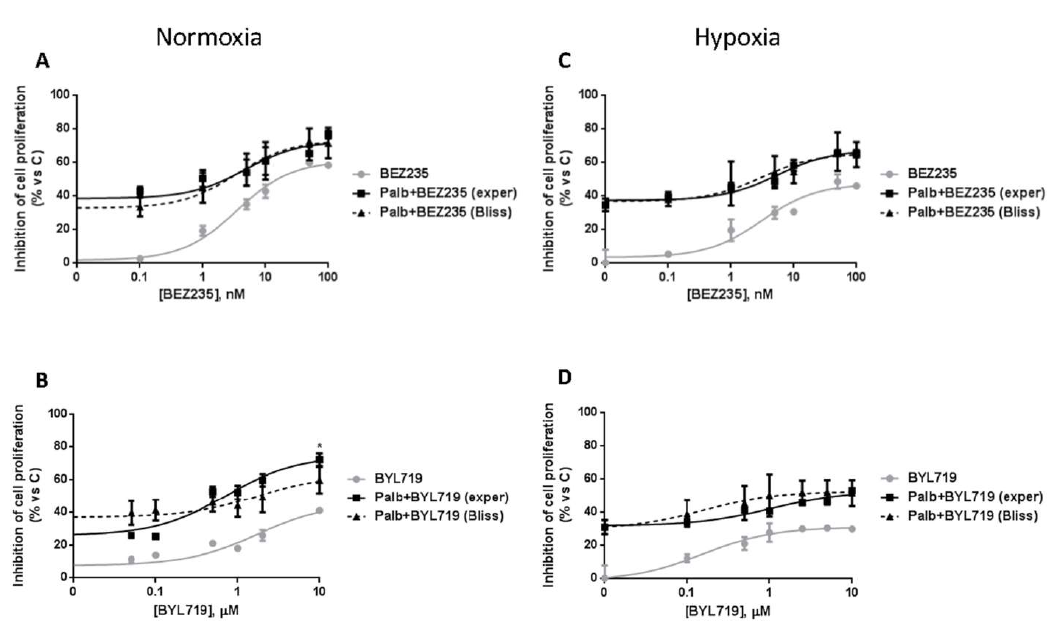
Figure 2. The combined treatment of palbociclib with PI3K / mTOR inhibitors inhibits cell proliferation of H2052 cells under normoxic and hypoxic conditions. H2052 cells were treated with palbociclib 1 µ M, combined with increasing concentrations of BEZ235 (from 0.1 nM to 100 nM) ( A , C ) or BYL719 (from 0.1 to 10 µ M) ( B , D ) for 72 h under normoxic ( A , B ) or hypoxic conditions ( C , D ). Cell proliferation was assessed by MTT assay. The type of interaction (antagonistic, additive or synergistic) was evaluated through Bliss analysis. Data are expressed as percent inhibition versus control cells and are representative of two independent experiments. * p < 0.05 vs.